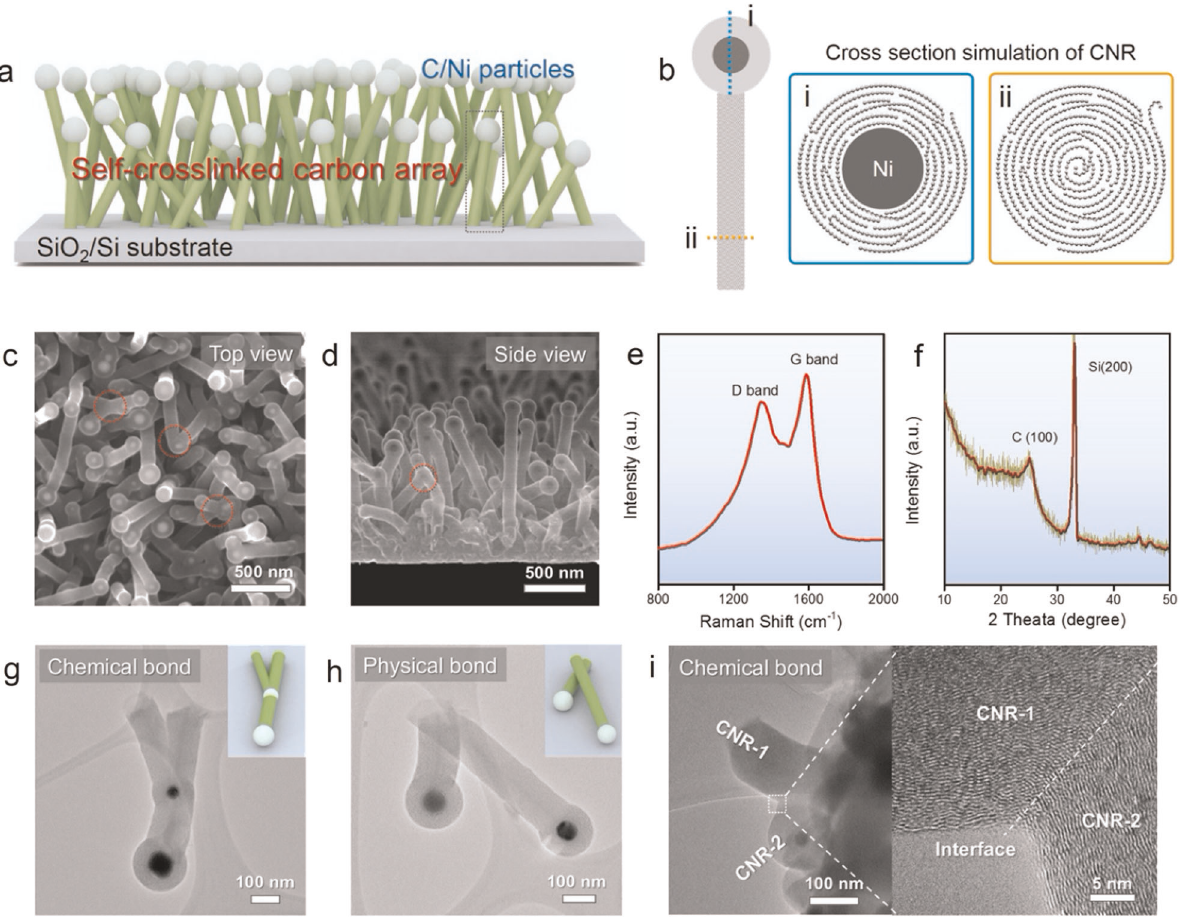
Fig. 2 Schematic structure of self-cross-linked carbon arrays and characterizations. a Schematic illustration of self-cross-linked carbon arrays. b The cross-section simulation of the CNR, suggesting that the individual unit of CNA is different than that of CNT and that it is an intermediate state between the CNT and carbon nano fi ber. Top view ( c ) and side view ( d ) SEM images of self-cross-linked CA show the individual unit vertically aligned to the substrate and cross-linked to each other. The contact points between the individual units are both strong chemical bonds and physical stacking interactions. e A typical Raman shift of the sample shows the amount of defects that exist in the prepared CNA. f XRD pattern shows a wide and weak peak at 25.1°, which indicates a layered structure with the interlayer spacing of ~0.35 nm in CNA. g, h, i TEM images of CNRs connected with chemical bond ( g, h ) and physical stacking ( i ),